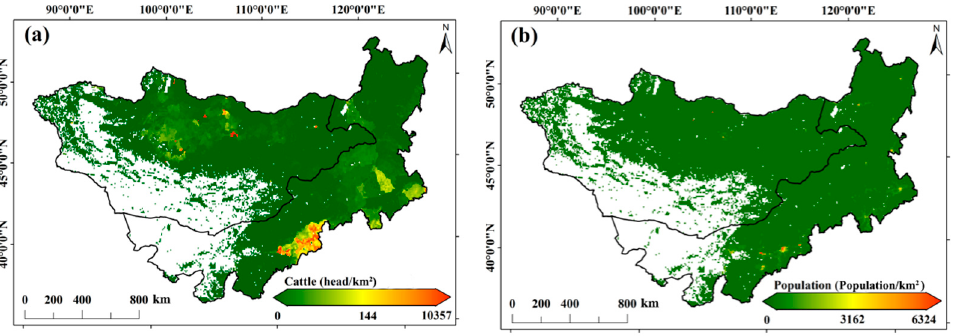
Figure 7. Distribution map of: ( a ) livestock and ( b ) population in the Mongolian Plateau. According to the spatial distribution of the SOS NPP , the SOS NPP in more than 21% of the regions we studied is related to precipitation and the snow melting date (Figure